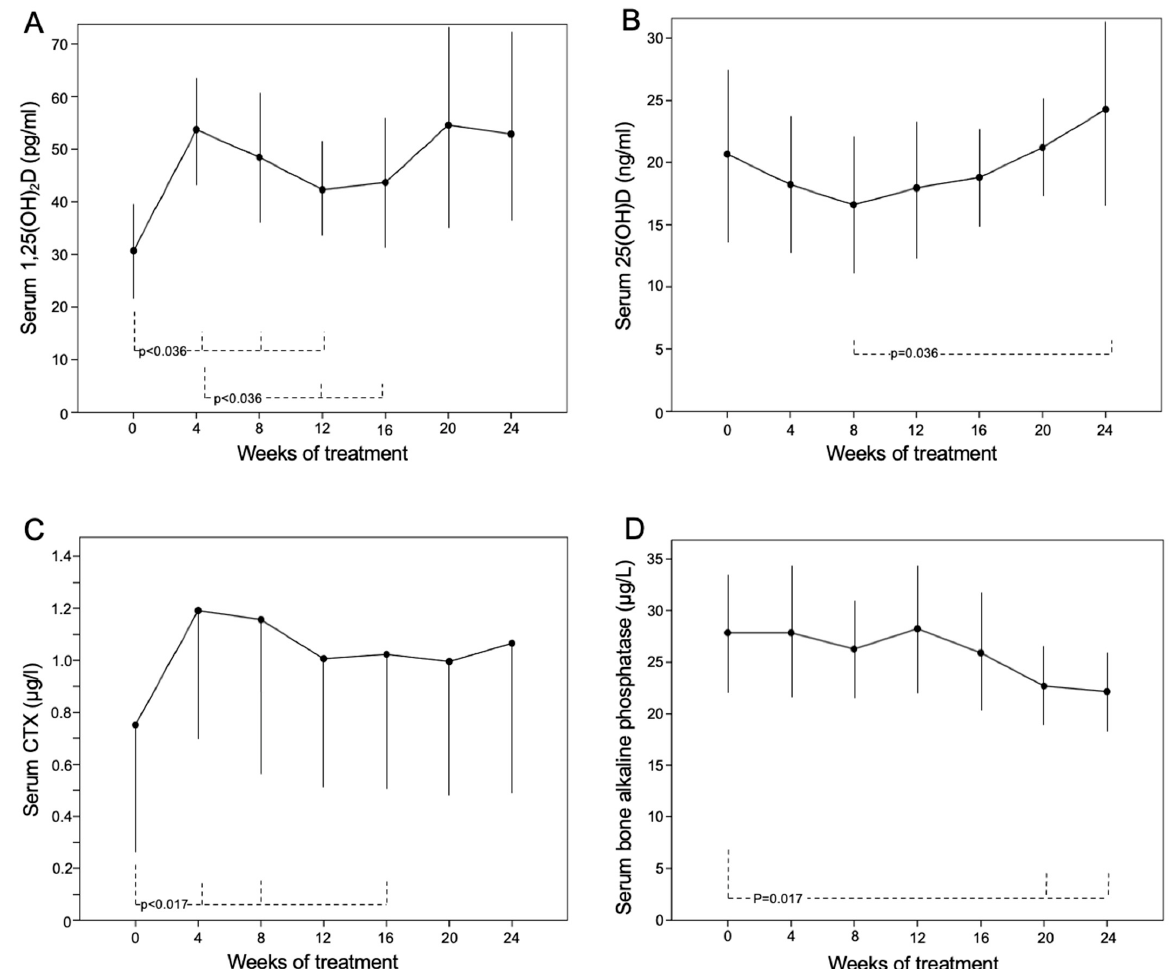
Figure 4. Serum values of ( A ) 1,25(OH) 2 D, ( B ) 25(OH)D, ( C ) CTX and ( D ) bALP during 24 weeks of treatment with burosumab (1 mg/kg body weight every 28 days) in 8 patients with XLH. Values of SMI did not change after 24 weeks of treatment with burosumab compared to baseline values (8.5 ± 1.5 [6–10] vs. 9.1 ± 1.3 [7.3–10.7], respectively; p = 0.31).